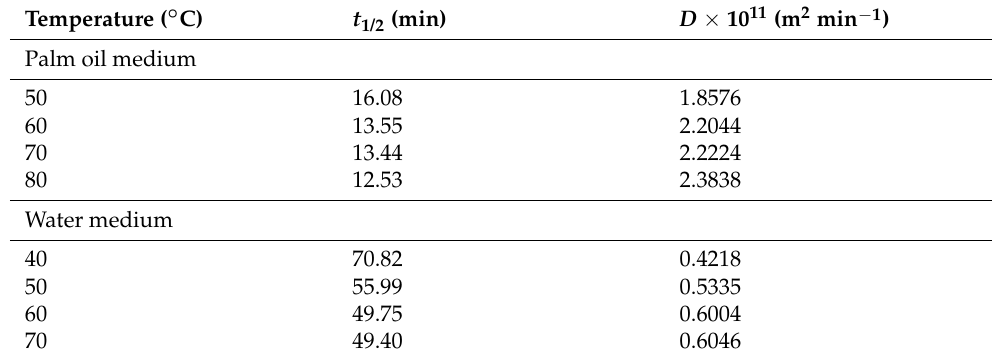
Table 2. Half-dyeing time and dye diffusion coefficient of Reactive Blue 194 dyeing raw ramie yarn. Temperature ( ◦